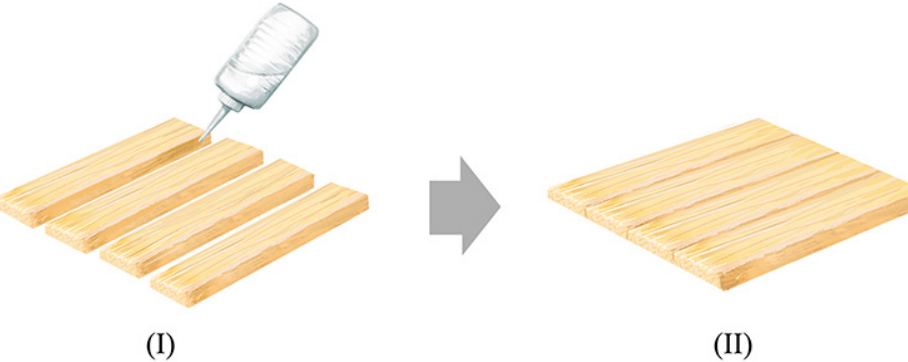
Figure 3. Buriti foam boards production: ( I ) bonding the layers of Buriti foam with the PVA adhesive, and ( II ) Buriti foam board.